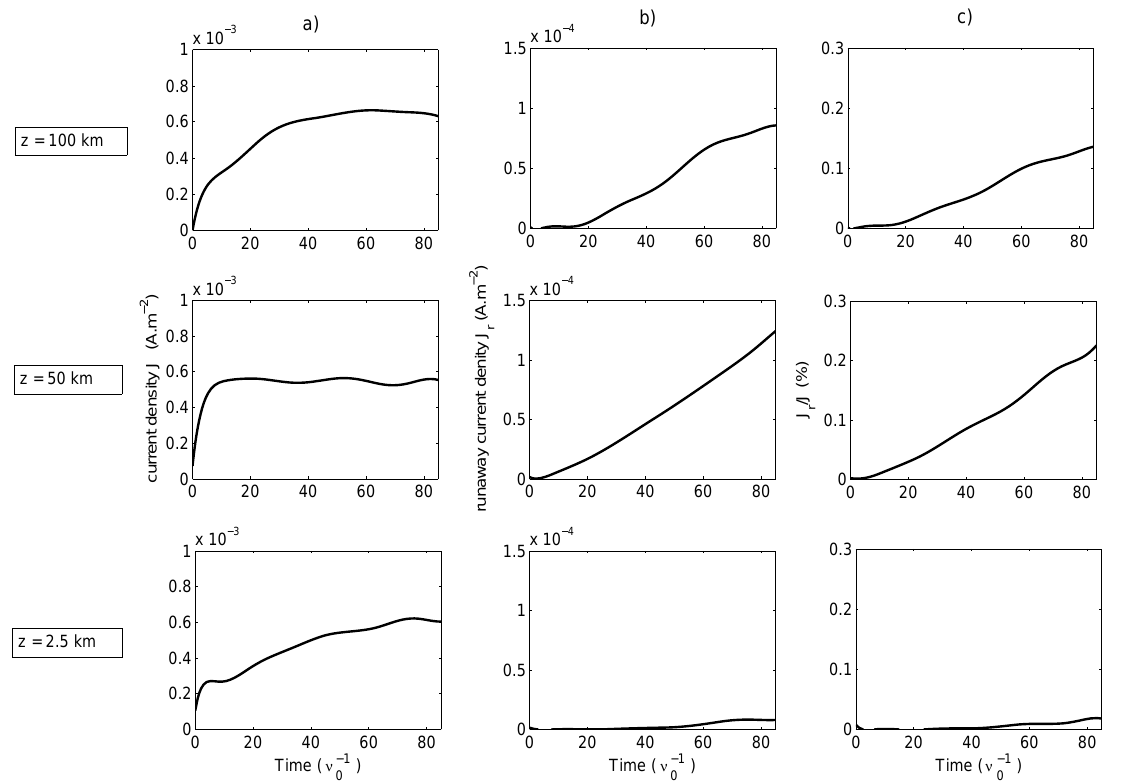
Fig. 7. The left column of panels represents the total current density as a function of normalized time. The middle column represents the runaway current density as a function of normalized time. The right column of panels shows the ratio of the runaway current density over the total current density as a function of normalized time. For the three columns, the top panels correspond to 100km altitude, the middle panels to 50km and the bottom panels to